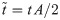
From continuous to discontinuous tissue heterogeneity: osteocyte density in one spatial dimension.Spatio-temporal plot of the density of osteocytes in one spatial dimension. The cells are assumed to be generated with uniform density at the moving deposition front, and to undergo cell death at constant rate. The variables t˜=tA/2 and z˜=zA/(2vf¯) are dimensionless time and space coordinates, where vf¯ is the time average value of vf(t). In these dimensionless coordinates, the solution is independent of A and vf¯. (a) Formation only, occurring at a deposition front moving with variable speed; (b) Sequence of formation followed by resorption with net positive balance, resulting in discontinuities (“patches”).